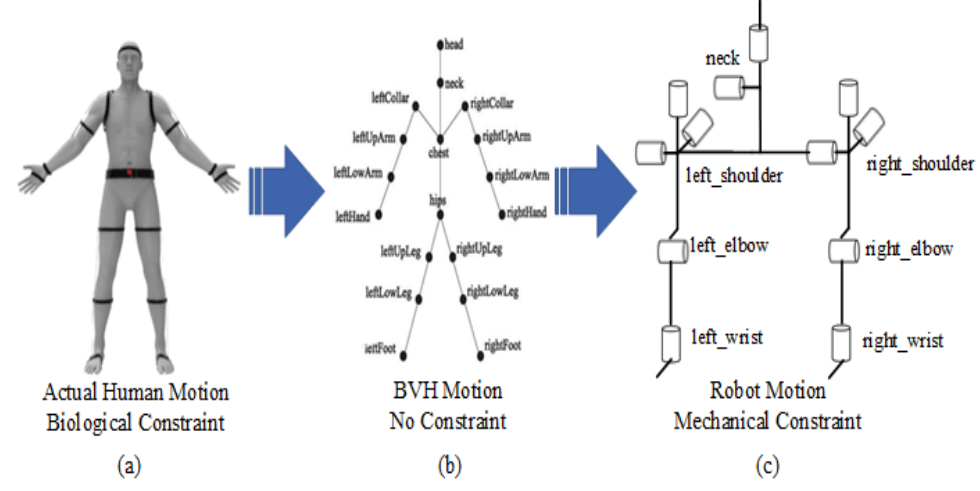
Figure 5. Three motion systems with different constraints. ( a ) shows the human motion system with biological constraint. ( b ) shows the BVH motion system with no constraint. ( c ) shows the robot motion system with mechanical constraint.